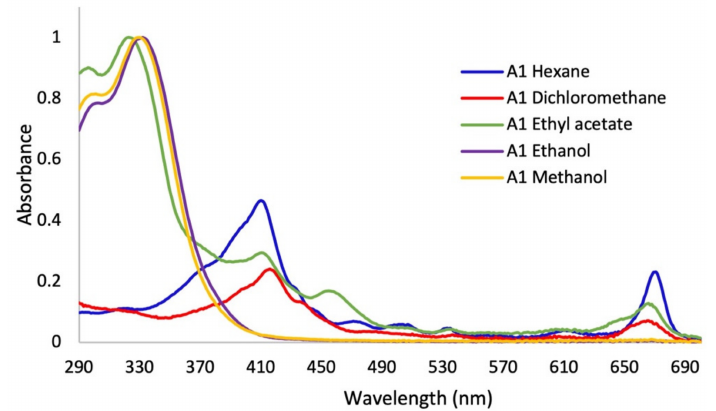
Figure 2. UV–Vis absorption spectra of Baccharis antioquensis sequential extractions in different solvents (Assay 1).